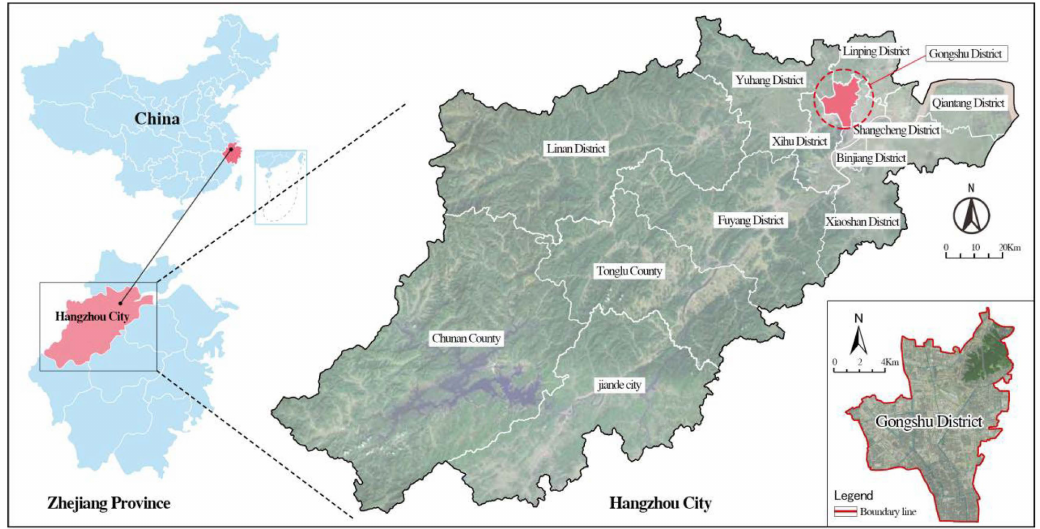
Figure 2. Case study area: Gongshu District, Hangzhou City, Zhejiang Province,